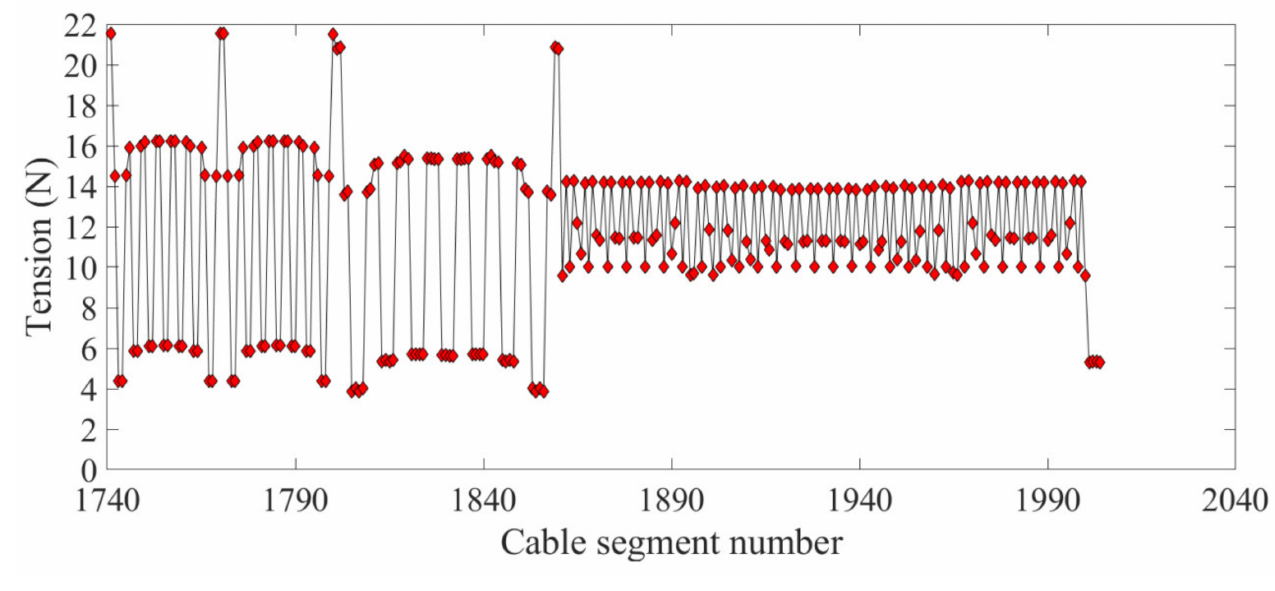
Figure 20. The boundary cable segment tension.